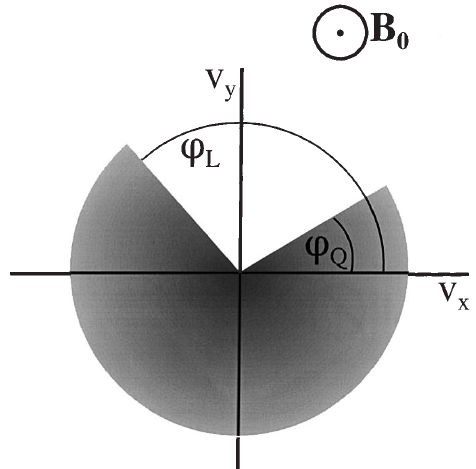
Fig. 1. Sketch of an open nongyrotropic distribution function. Positively charged ions ( shaded region ) enter the velocity space at u and leave it at u L